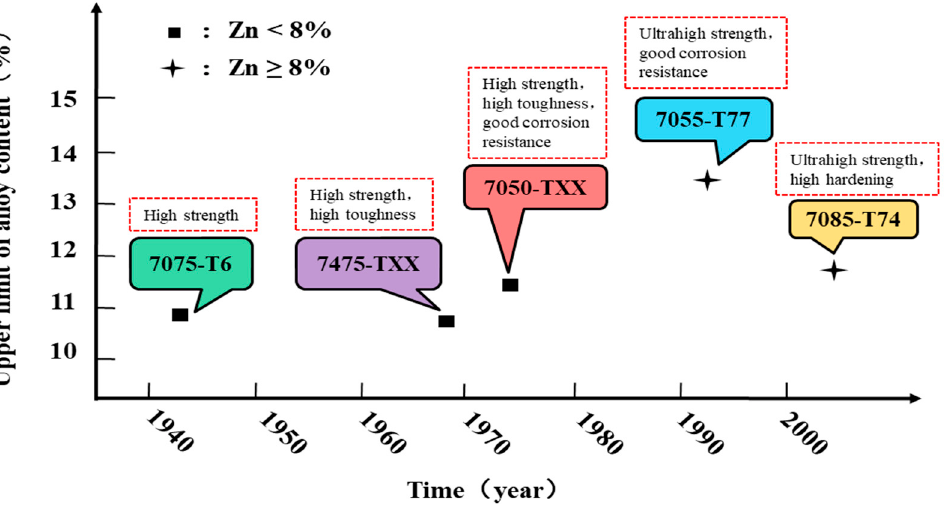
Figure 5. The development process of Al 7XXX alloys [2,13,26,30].